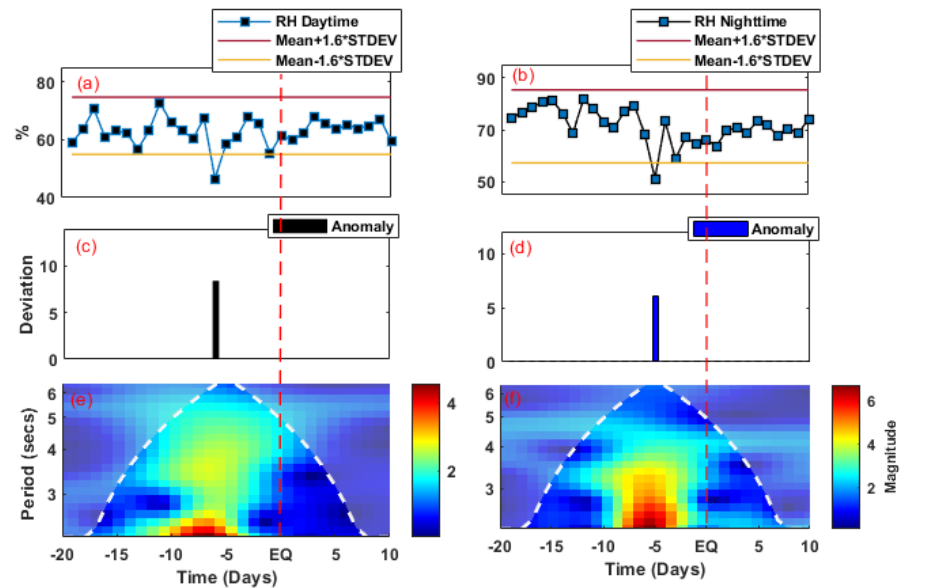
Figure 4. ( a ) Daytime RH averaged time series data with confidence bounds, ( b ) Time series data of RH nighttime with confidence bounds, ( c ) The deviation of daytime RH values from confidence bounds, ( d ) Nighttime RH deviation from pre-defined bounds, ( e ) Wavelet transformation of daytime RH data, ( f ) Wavelet transformation analysis of nighttime RH time series data. The white dashed line in Figure 5e,f marks cone of influence and red dashed line shows the earthquake day. The * is for multiplication.